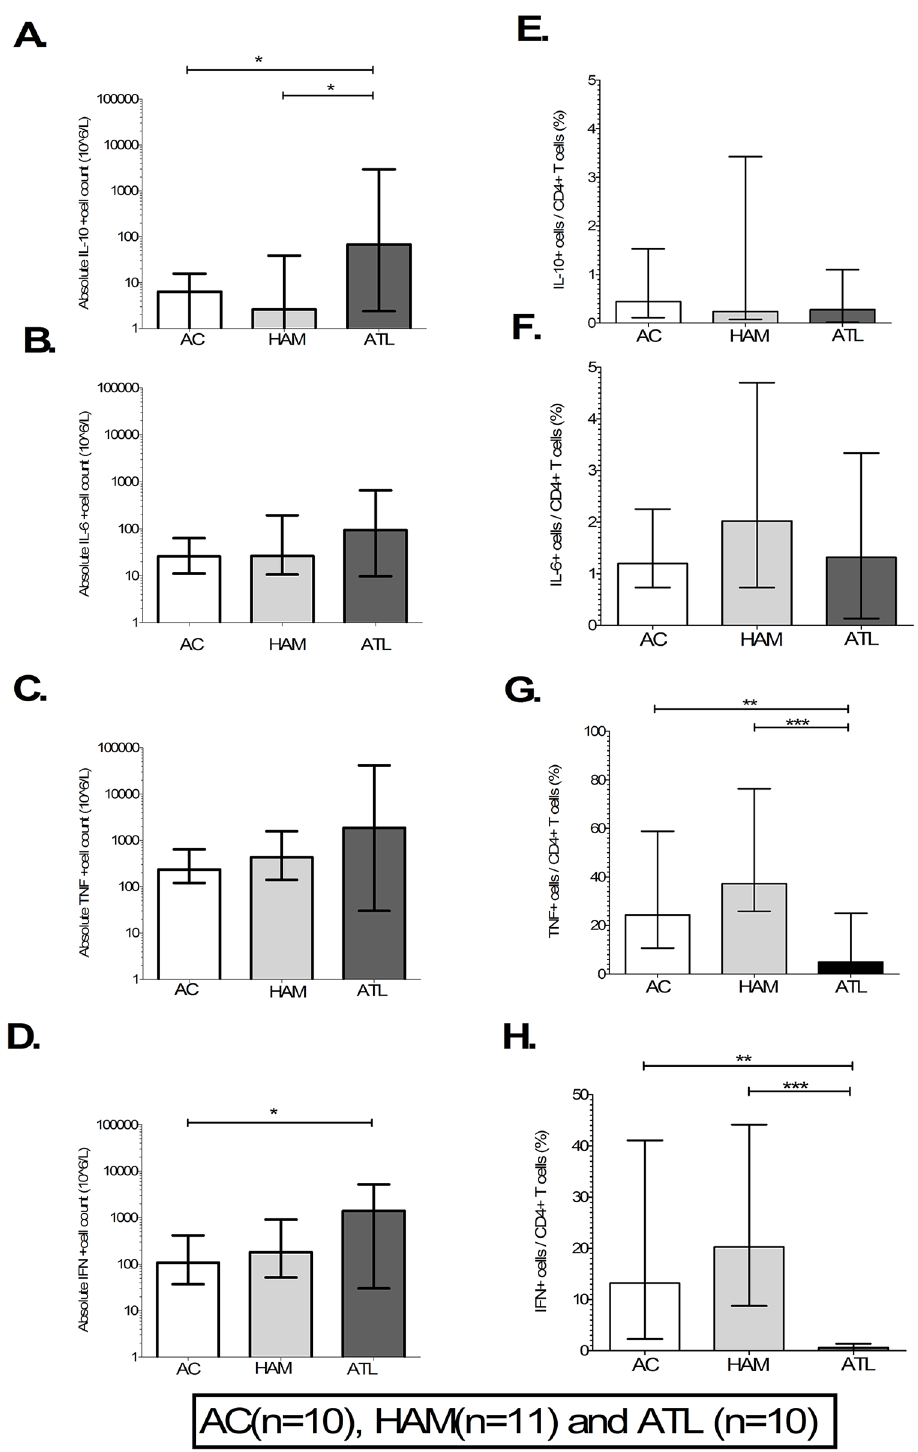
Fig 4. CD4+T-cell cytokine producing profile in non-ATL HTLV-1 infection and ATL. A-H) Bar column plots showing absolute and relative frequency of CD4+T cells in asymptomatic carriers (AC), patients with HTLV-1 associated myelopathy (HAM) and adult T-cell leukaemia/lymphoma (ATL). The bar represents mean values and error bar the standard deviation. Statistical analysis: Kruskal-Wallis test with Dunn post-test, 95% confidence interval and Wilcoxon signed rank test. (cid:3) denotes p < 0.05, (cid:3)(cid:3) denotes p < 0.01, (cid:3)(cid:3)(cid:3) denotes p < 0.001.